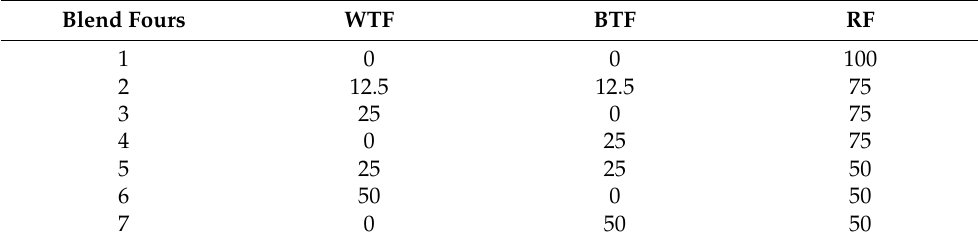
Table 1. Blend flour formulations in percentage (%). Abbreviations: RF: rice flour, WTF: white teff flour, BTF: brown teff flour.